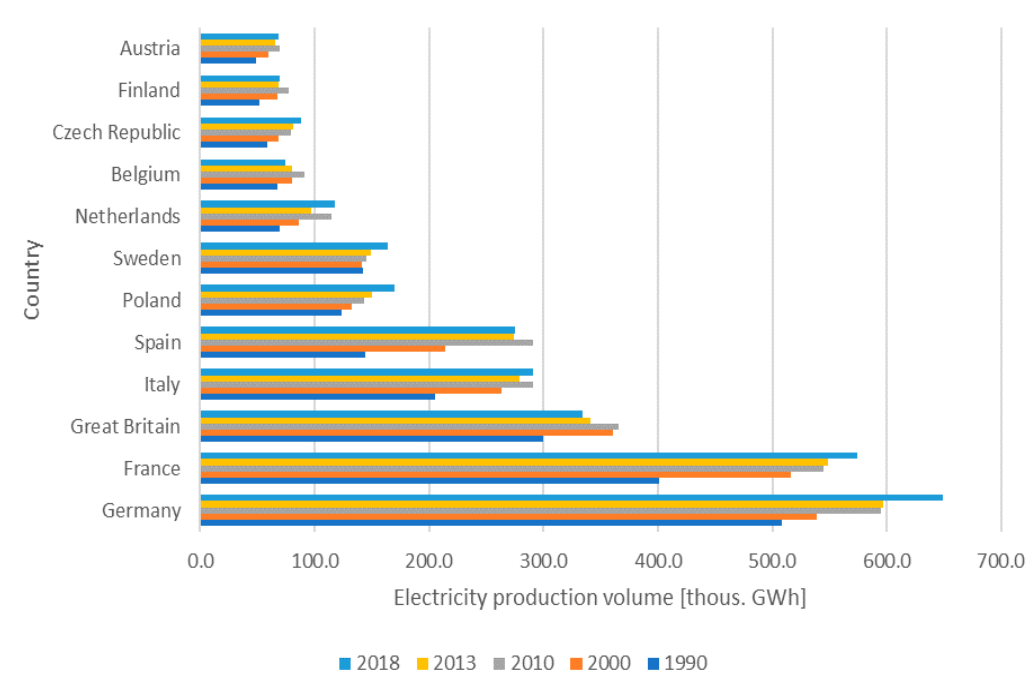
Figure 1. Electricity production volume in selected EU countries in the years 1990–2018, thousand GWh, source: own study based on data [13].